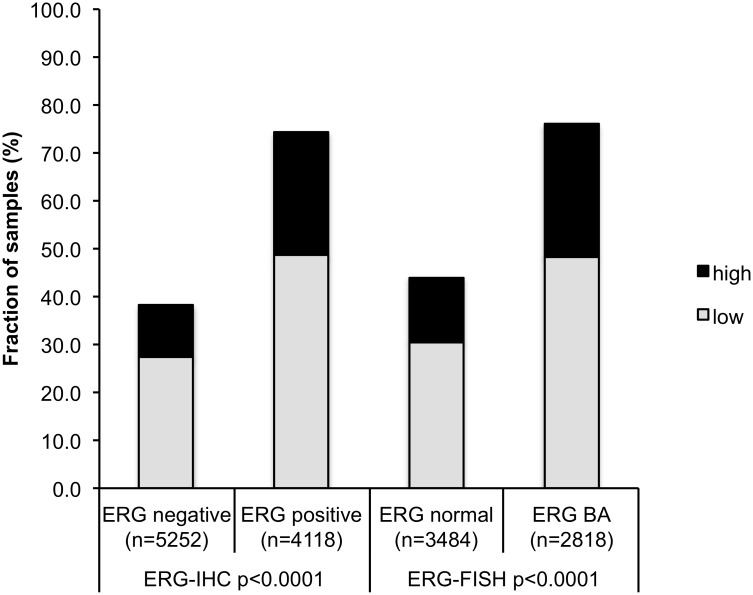
Relationship of HOOK3 expression with ERG status.IHC = immunohistochemistry; FISH = fluorescence in-situ hybridization.